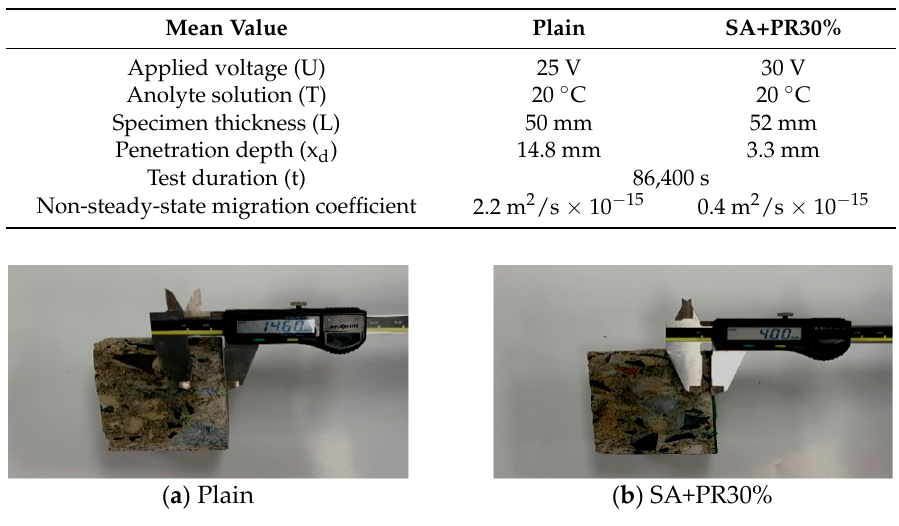
Figure 7. Chloride penetration measurement.